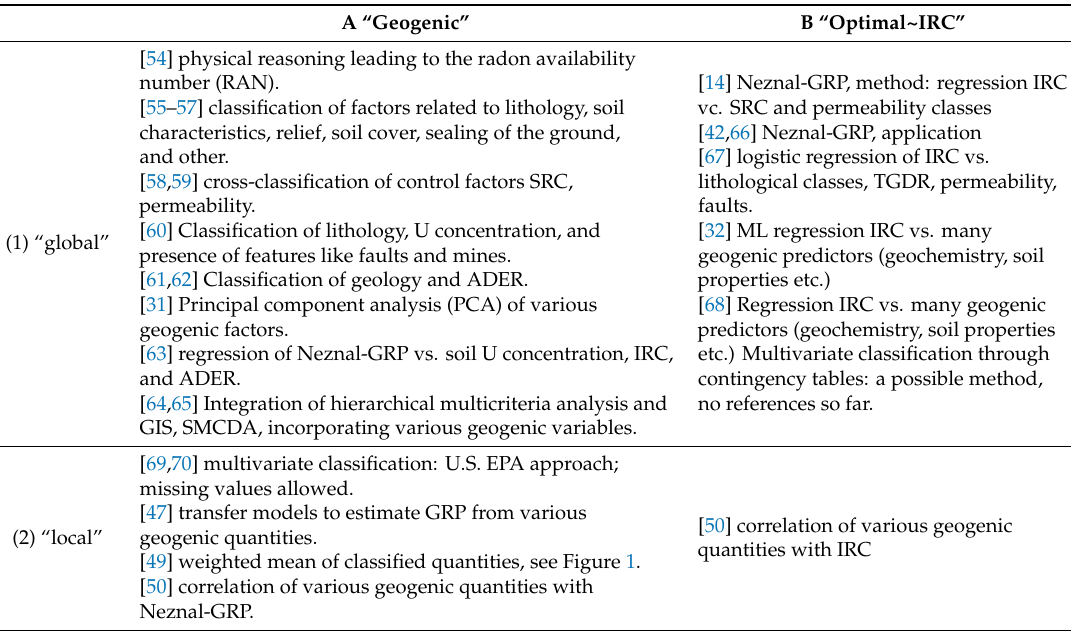
Table 1. Taxonomy of GRHI definitions. See Section 3.3 for more